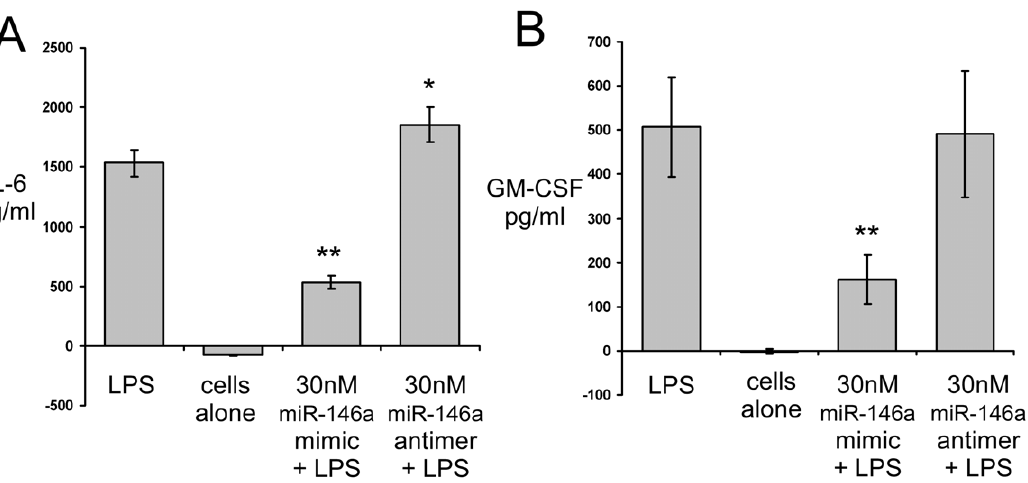
Figure 7. EOC 13.31 cells were transfected with 30 nM of miR-146a mimic or anti-miR and 16 hrs later stimulated with 10 ng/ml LPS. At 24 hours post LPS stimulation, culture supernatant was collected and the levels of IL-6 and GM-CSF (coded for by the gene CSF2) were determined by ELISA; significance: ** p , 0.001, * p , 0.01.